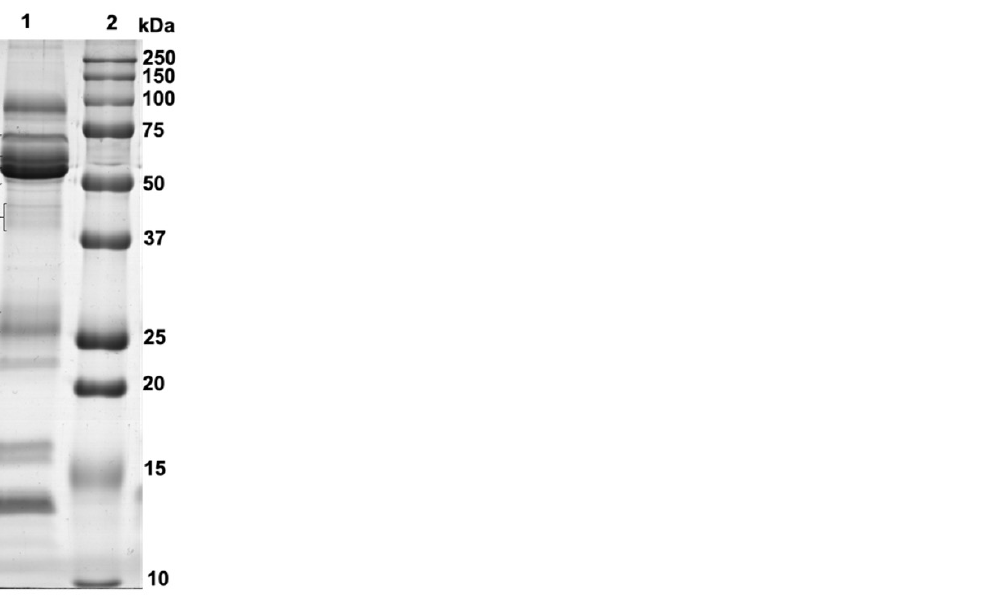
Figure 2. Representative salivary protein profile (1—saliva samples; 2—molecular mass marker; letters represent the 12 different protein bands analyzed). Table 1. Variations in saliva composition between Mediterranean Diet (MD) adherence and Body Mass Index (BMI) groups (means ± SD): a two-way general linear